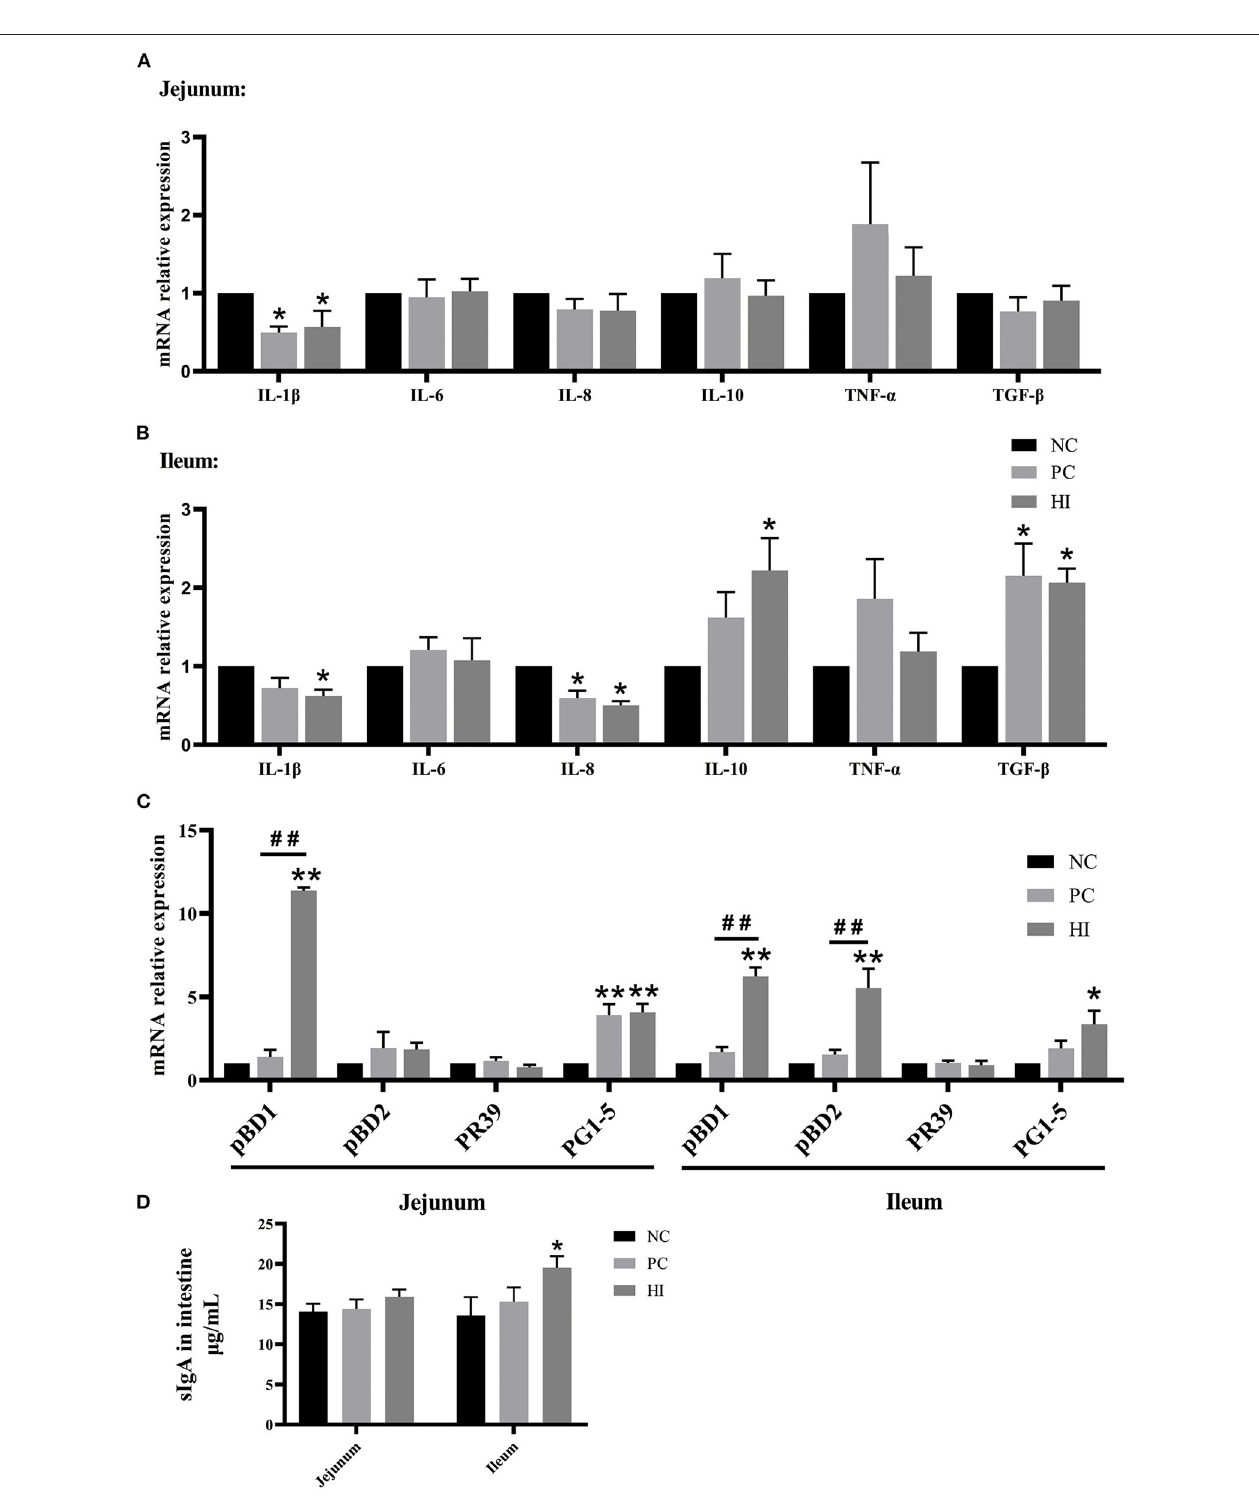
FIGURE 3 | Effect of dietary Hermetia illucens larvae on intestinal immunity of weaned pigs. Real-time quantitative PCR was performed to determine the relative mRNA expression levels of IL-1 β , IL-6 , IL-8 , IL-10 , TNF- α , and TGF- β in the jejunum (A) and ileum (B) . (C) Real-time quantitative PCR was performed to determine the relative mRNA expression levels of pBD1 , pBD2 , proline-arginine rich 39-amino acid peptide ( PR39 ), and PG1-5 in the jejunum and ileum. (D) Concentration of sIgA in the jejunum and ileum determined using ELISA. All data are expressed as the mean ± SEM ( n = 6). * p < 0.05, ** p < 0.01 compared with NC, ## p < 0.01 HI compared with